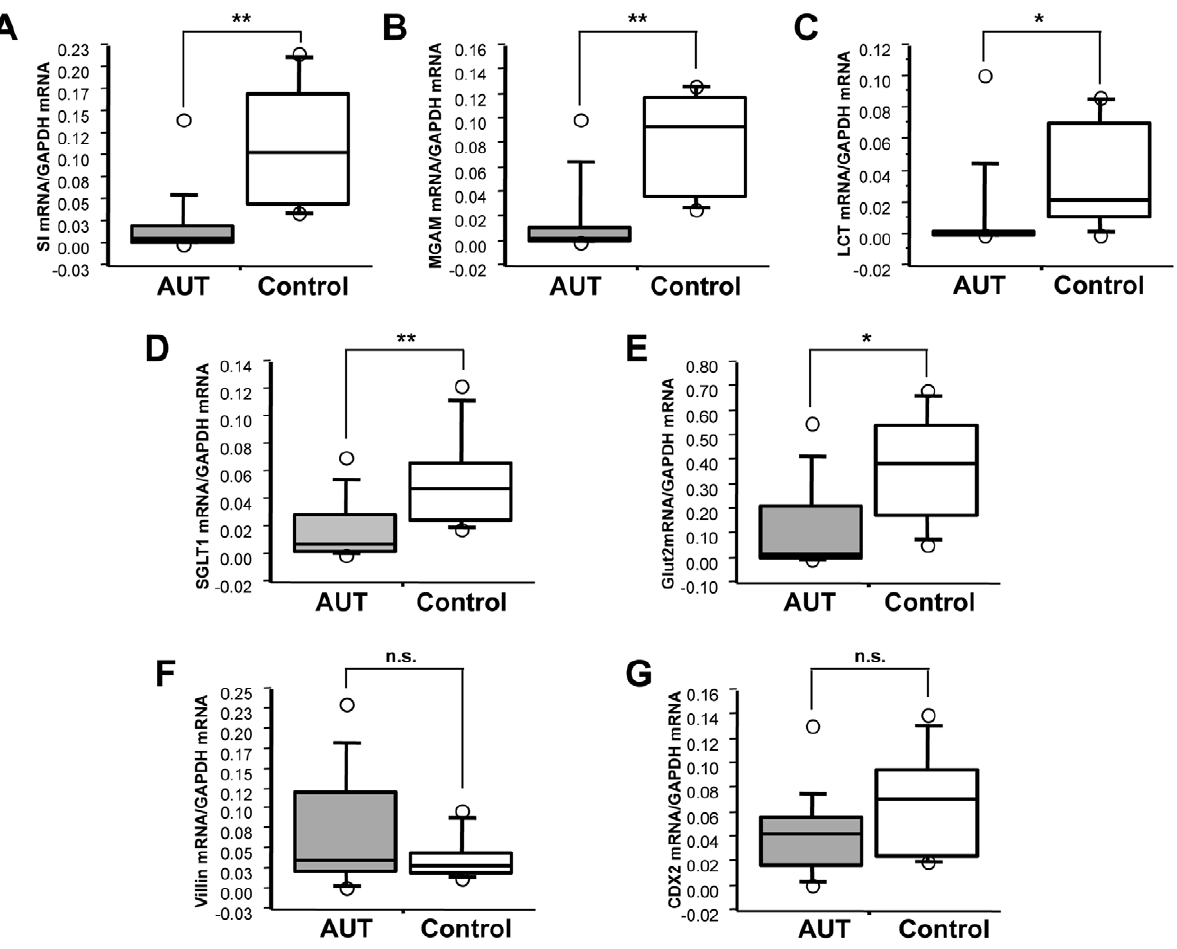
Figure 1. Quantitative real-time PCR analysis of disaccharidases, hexose transporters, villin and CDX2 transcripts. Box-and-whisker plots displaying ( A ) SI (Mann-Whitney; p =0.001), ( B ) MGAM (Mann-Whitney; p =0.003), ( C ) LCT (Mann-Whitney; p =0.032), ( D ) SGLT1 (Mann-Whitney; p =0.008), ( E ) GLUT2 (Mann-Whitney; p =0.010), ( F ) Villin (Mann-Whitney; p =0.307), and ( G ) CDX2 (Mann-Whitney; p =0.192) mRNA expression normalized to GAPDH mRNA in ileal biopsies from AUT-GI (AUT) and Control-GI (Control) patients. *, p , 0.05; **, p , 0.01; n.s., not significant.